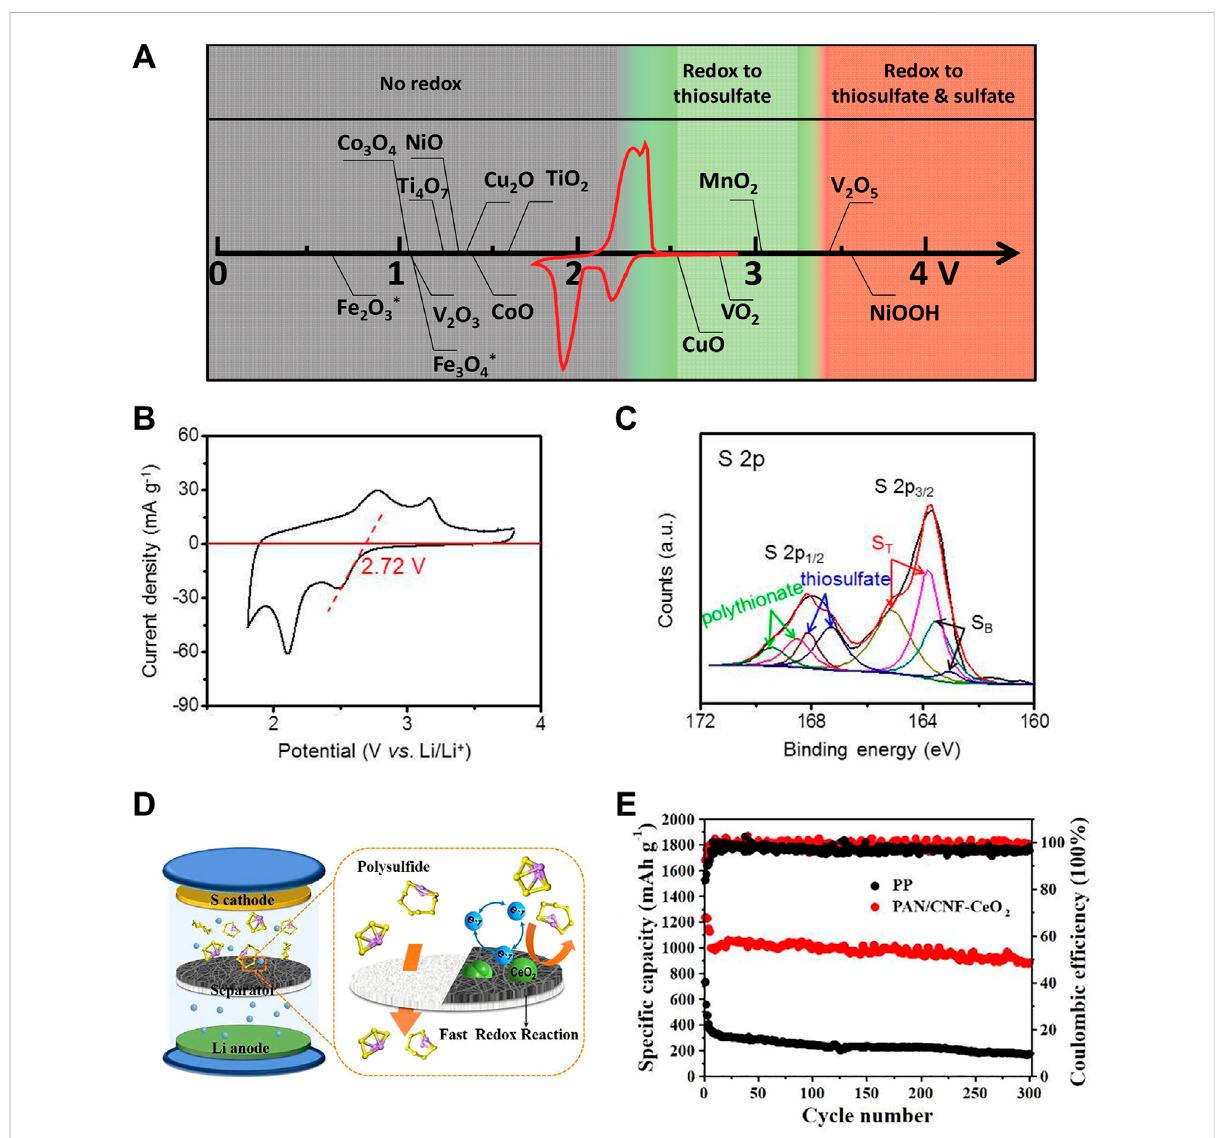
FIGURE 12 Applications of CeO 2 in Li-S batteries: (A) Chemical reactivity of different metal oxides with LiPSs as a function of redox potential versus Li/Li + , superimposedwithatypicalLi-Scyclicvoltammetrycurve.Reproducedwithpermission(Liangetal.,2016).Copyright2016,WileyOnlineLibrary. (B) Chemical reactivity of CeO 2 . (C) High-resolution XPS spectrum at S 2 p region after the adsorption test of Li 2 S 4 with CeO 2 /MMNC. Reproduced with permission (Ma et al., 2017). Copyright 2017, American Chemical Society. (D,E) Catalytic mechanism and performance of a Li-S battery with PAN/CNF-CeO 2 interlayer. Reproduced with permission (Zhang J. et al., 2020). Copyright 2020,